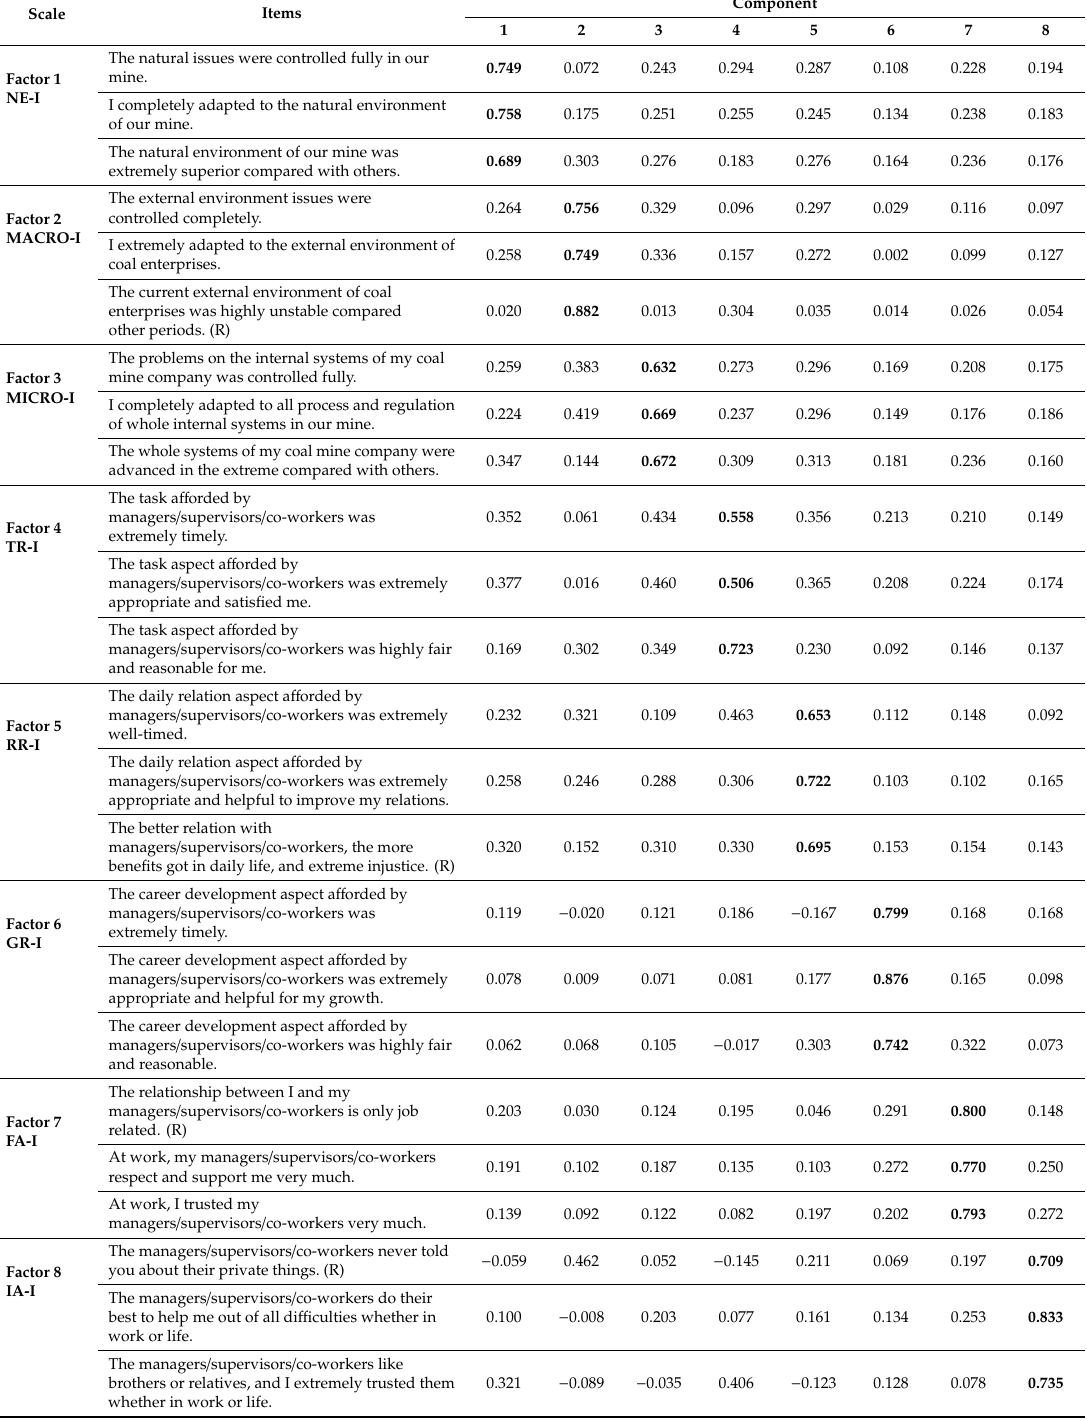
Table A3. The factor loading matrix of psychology